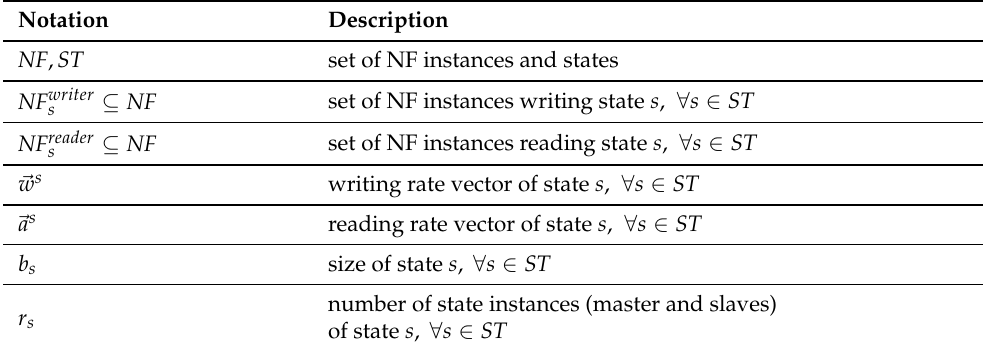
Table 3. Mathematical notations in Section